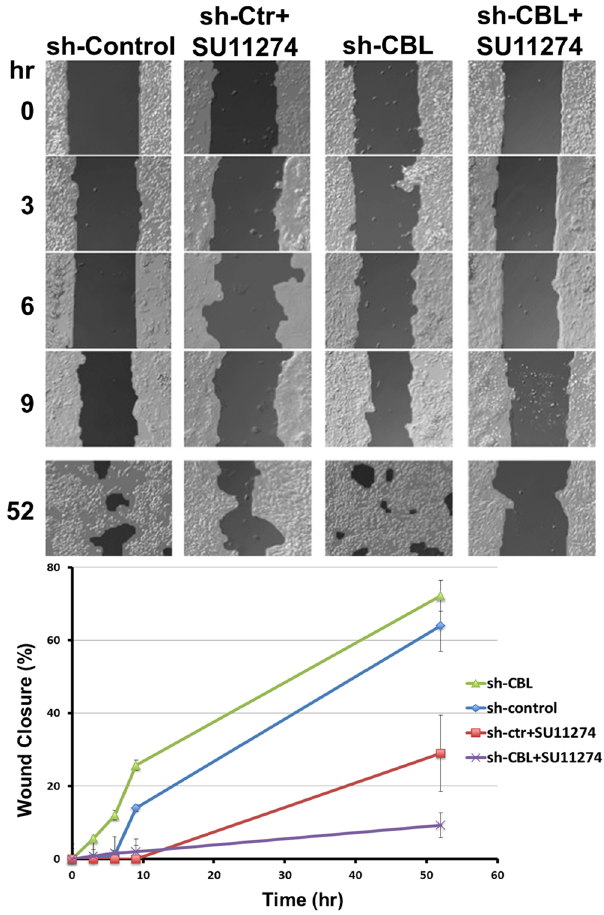
Figure 3. Cell migration of sh-CBL cells treated with MET inhibitor SU11274. Wound healing assay was performed in H358 sh-control and sh-CBL cells. The results showed sh-CBL cells had higher migration ability than sh-Control cells. After treated with MET inhibitor SU11274, sh-CBL cells had more sensitive migration inhibition by SU11274 than sh-control